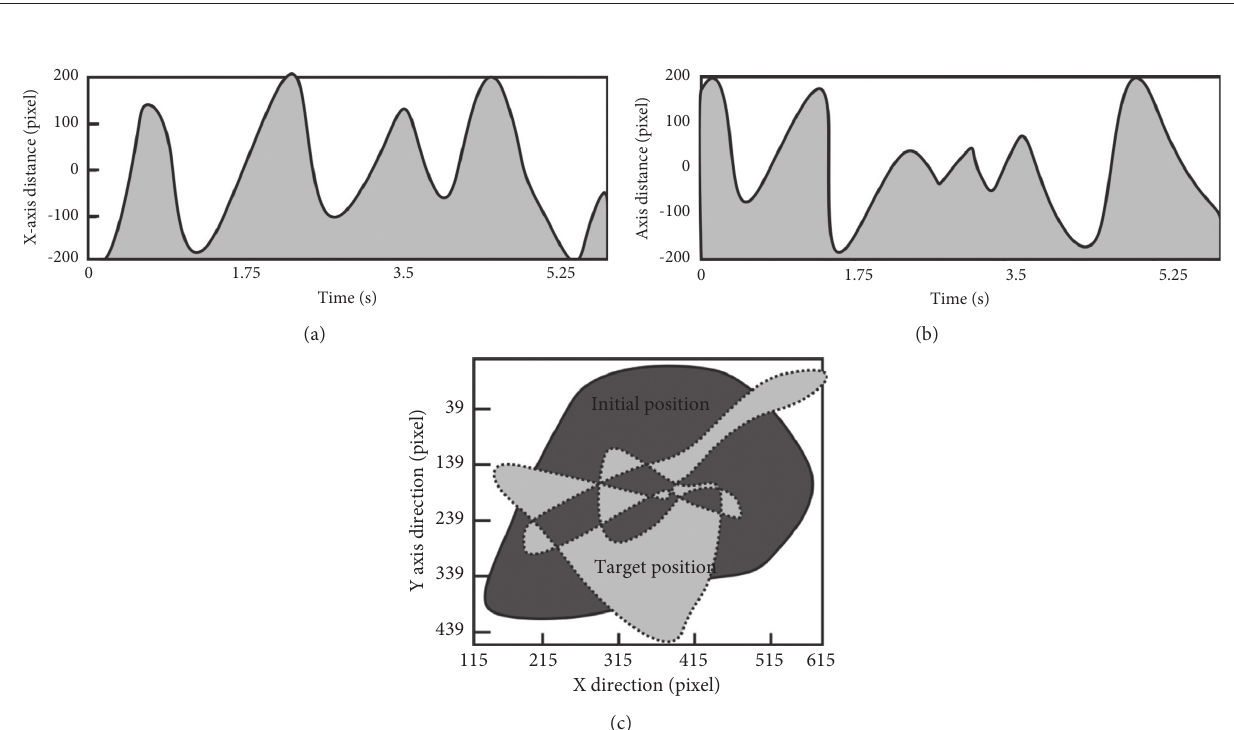
Figure 6: Search method of sports position in sports